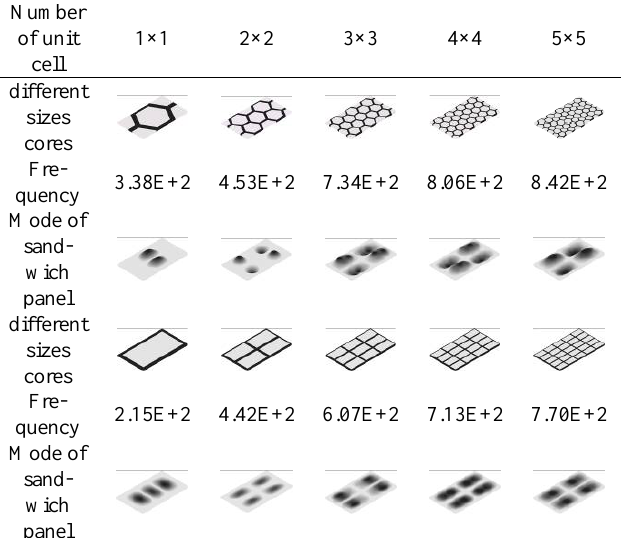
Table 12. The fifth order vibration response with the